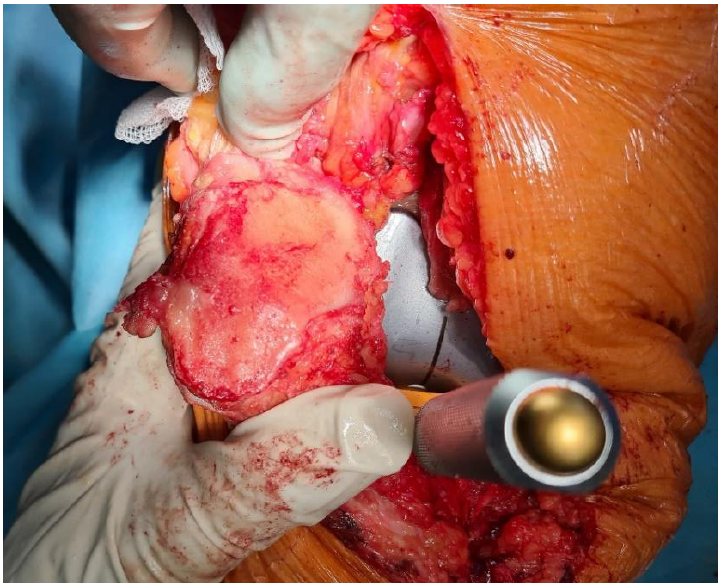
Figure 2. Luxation of patella for evaluation of patellar cartilage during trial placement of TKR com- ponents.